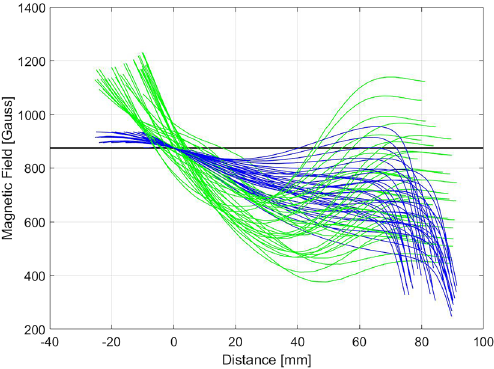
Figure 11. Superimposition of magnetic field profiles of different magnetic configurations of HSMDIS